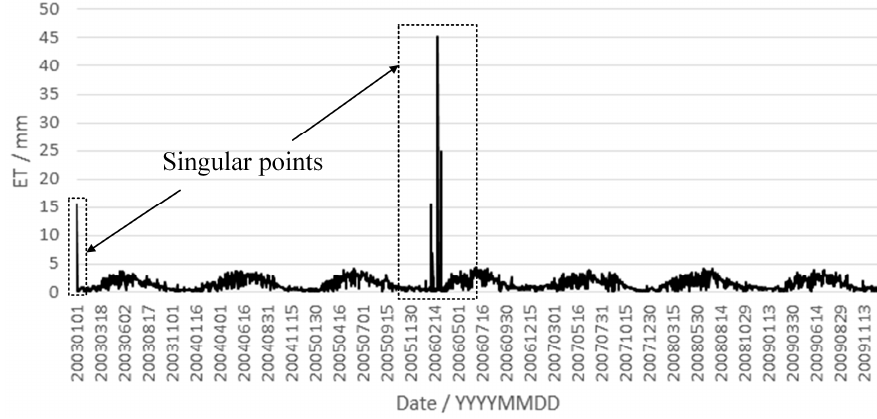
Figure 8. Simulated evapotranspiration of CREST 2.x (including singular points).